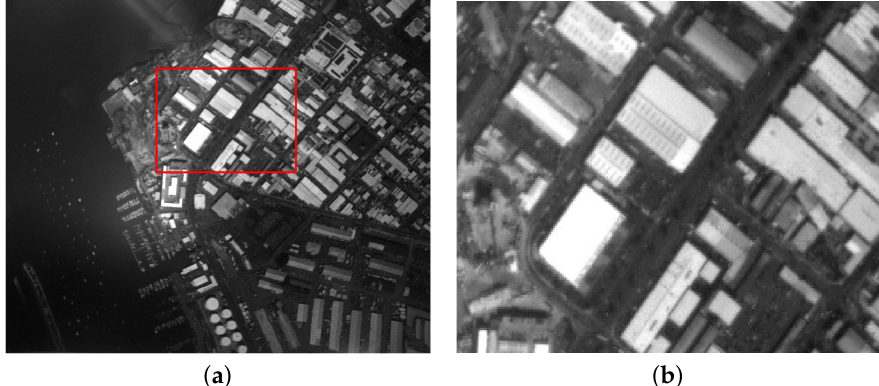
Figure 7. ( a ) Image taken with defocus; ( b ) enlarged view of the marked